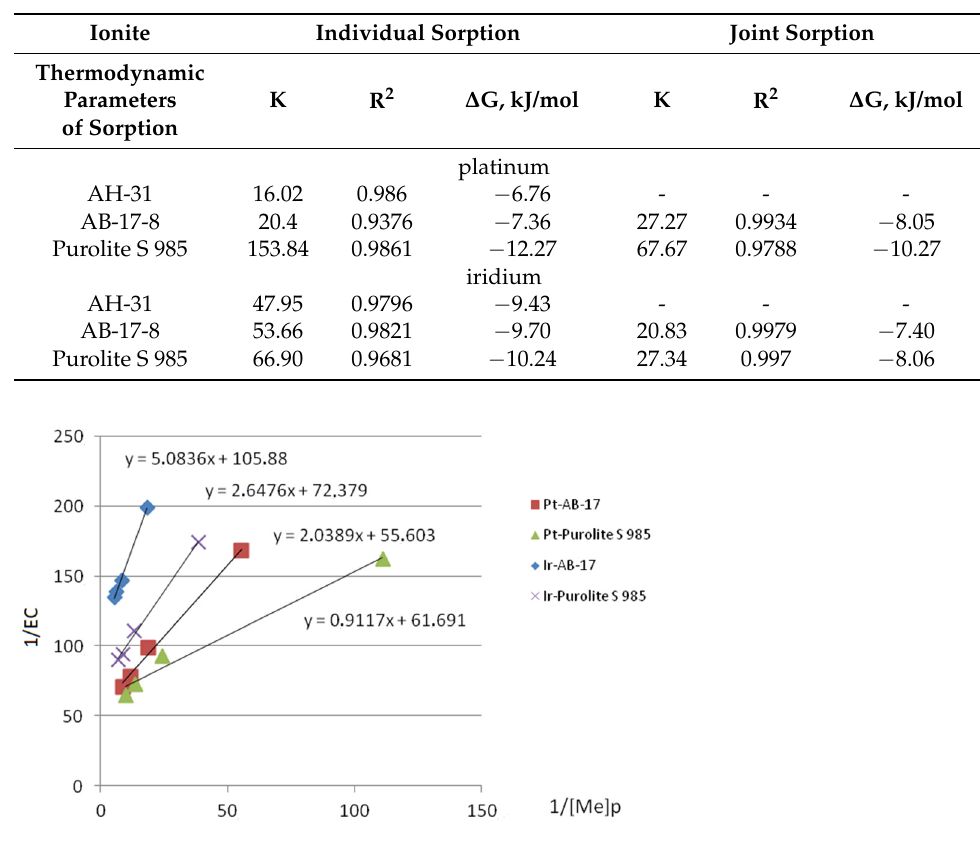
Table 3. Apparent constants of sorption equilibria, regression coefficients and standard Gibbs energy values of ion exchange of platinum and iridium sorption from individual and combined sulfate-chloride solutions.